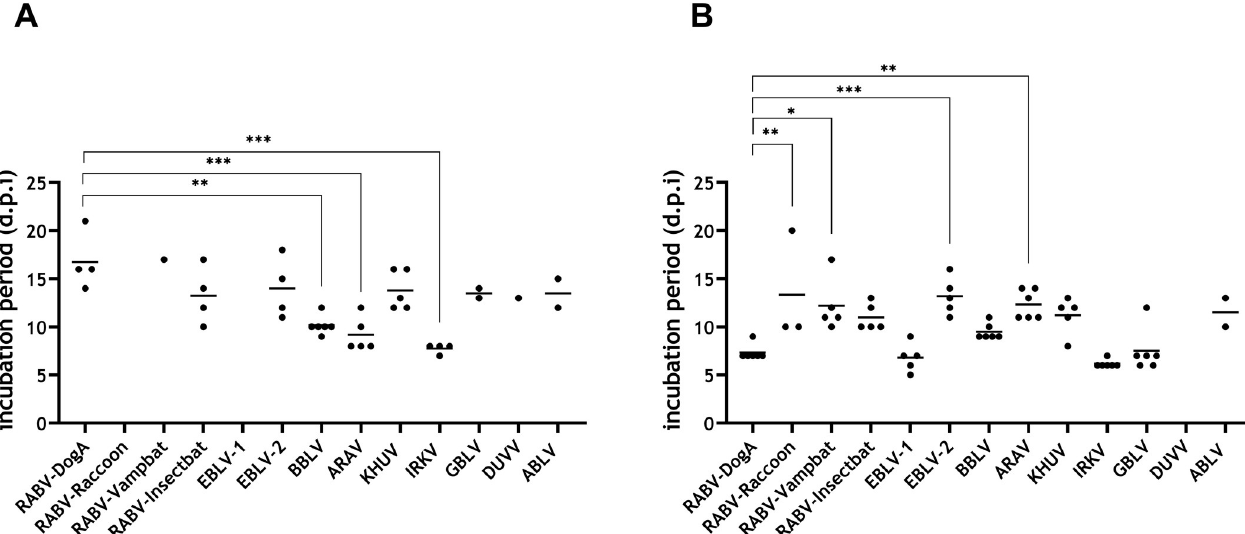
Fig 4. Incubation periods after low dose (A) and high dose (B) i.m. infection. Mean values are provided as horizontal lines. Statistical differences between the mean of RABV-DogA as a reference challenge strain and the means of other lyssaviruses are indicated ( � p � .05; �� p � .01; ��� p � . 001; ordinary one-way ANOVA with Tukey’s multiple comparison